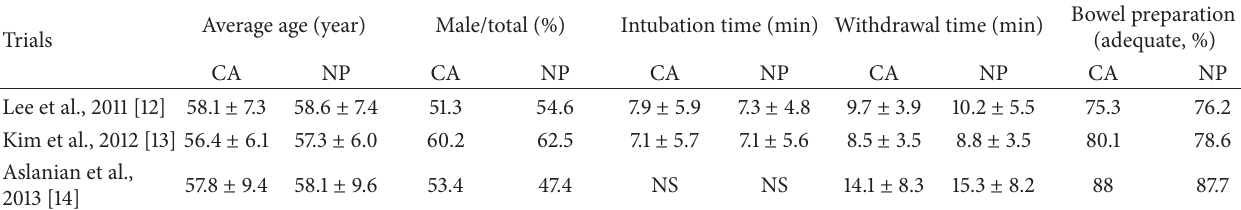
Table 2: Characteristics of patients in the included